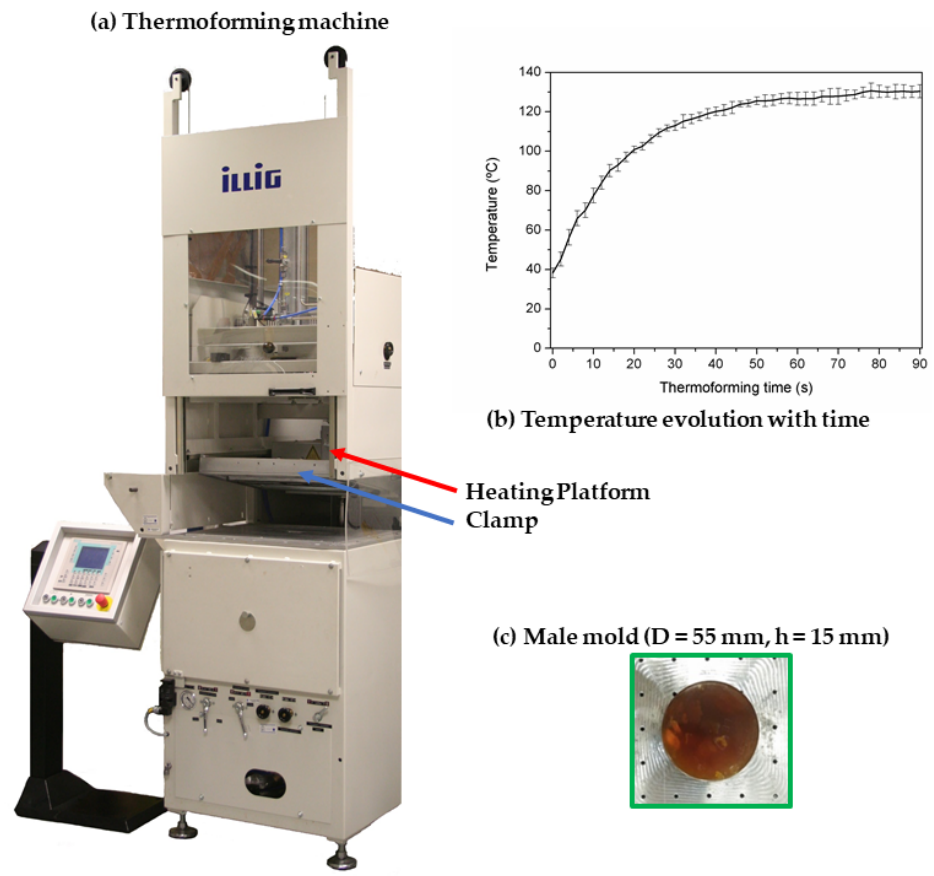
Figure 2. Image of the ( a ) thermoforming facility; ( b ) evolution of temperature with time at this processing conditions; and ( c ) male mold.